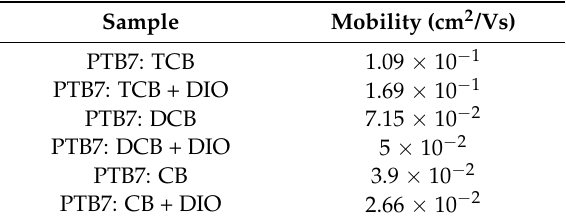
Table 2. Mobility of the samples.